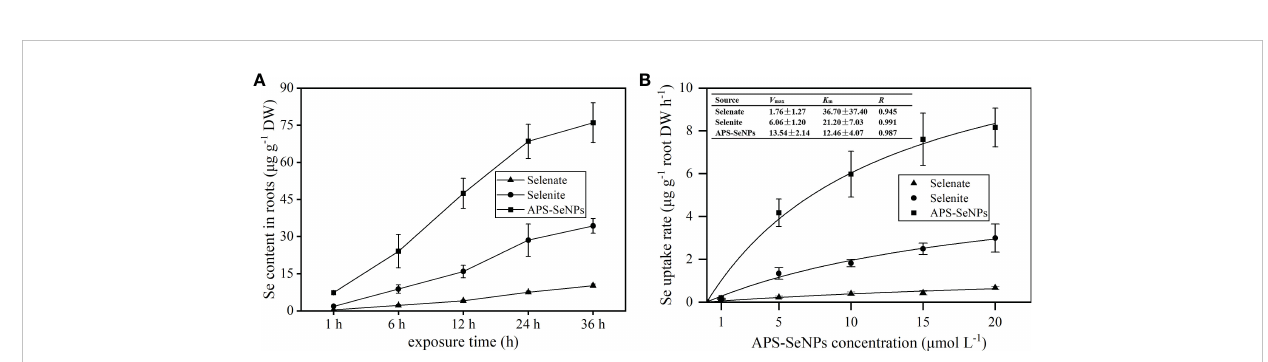
FIGURE 2 Time- (A) and concentration-dependent (B) kinetics of algal polysaccharides – selenium nanoparticles (APS-SeNPs), selenite, and